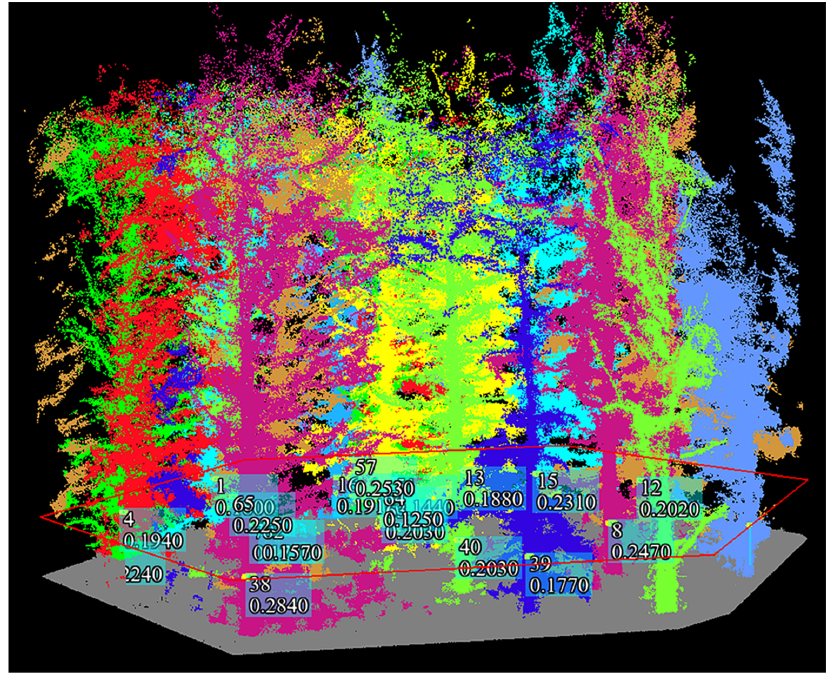
Figure 5. Individual tree